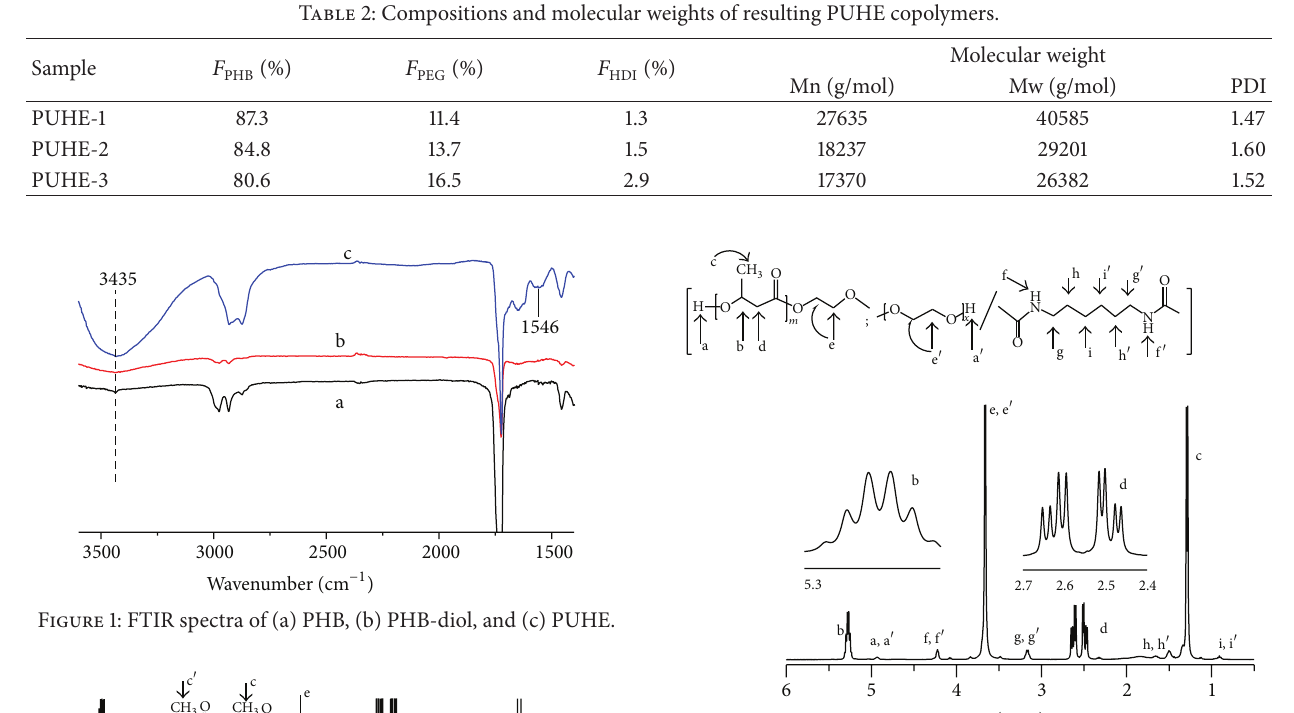
Figure 3: 1 H NMR spectra of polyurethane PUHE.